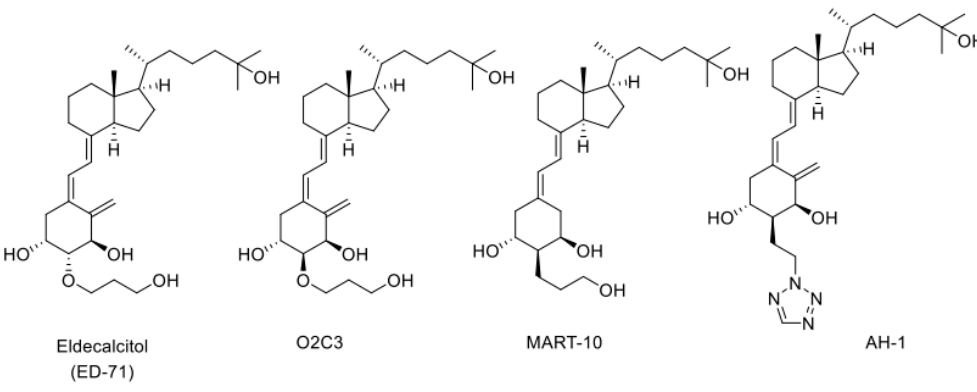
Figure 4. Structures of three CYP24A1-resistant VDR agonists: Eldecalcitol (ED-71), O2C3, MART-10, and AH-1.